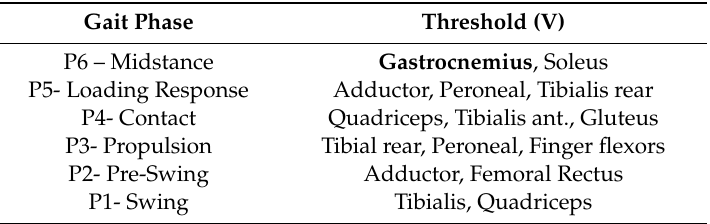
Table 3. Muscles involved by the specific gait phase.